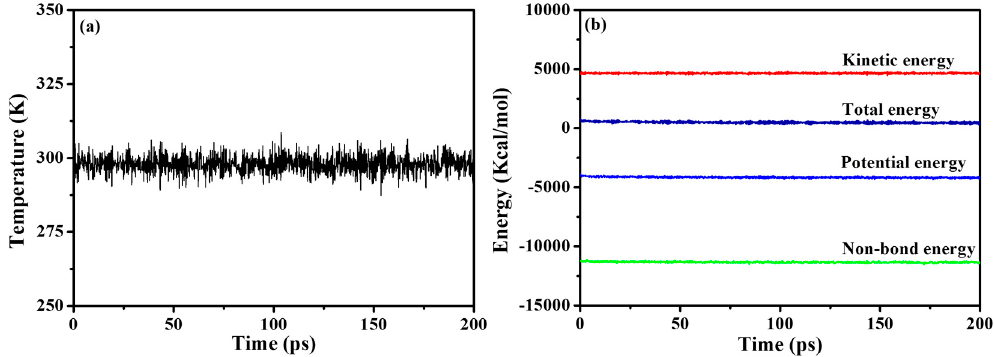
Figure 6. Temperature ( a ) and energy ( b) of PMA/SiO 2 nanocomposite at a temperature of 298K during the MD simulation.